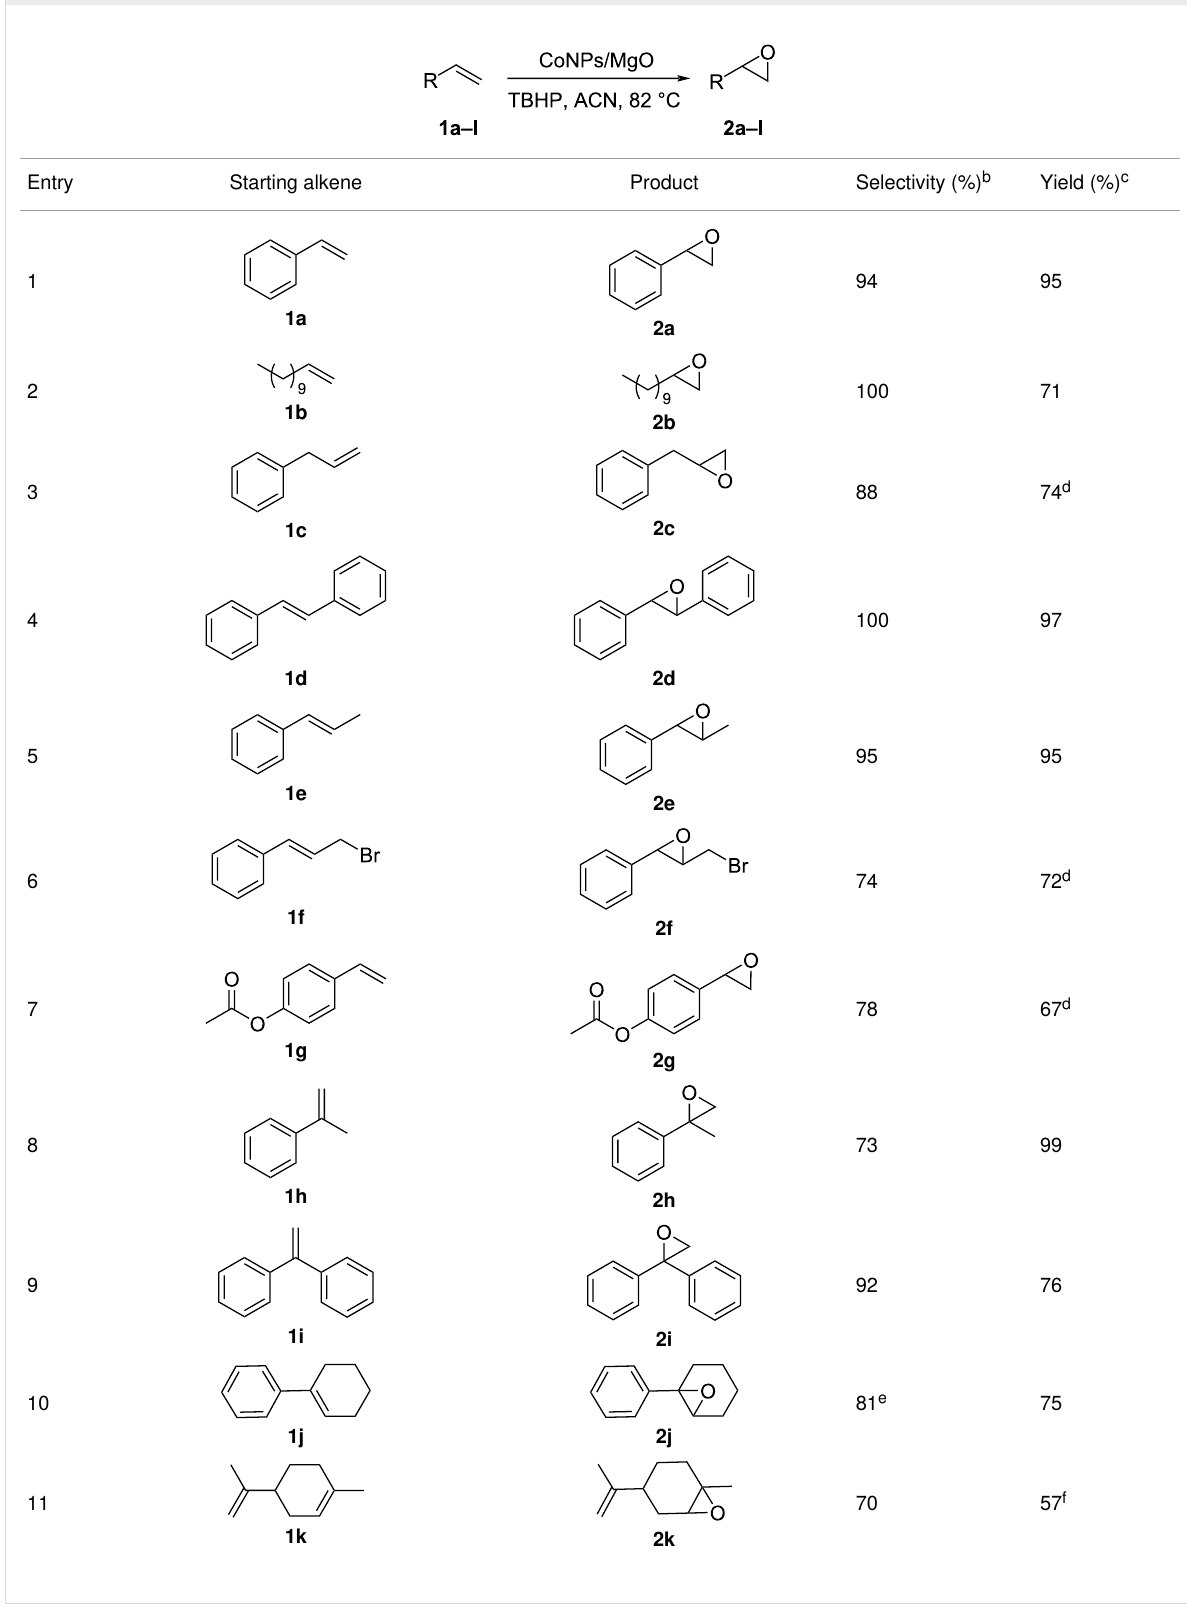
Table 2: Epoxidation of various alkenes under the optimized conditions.